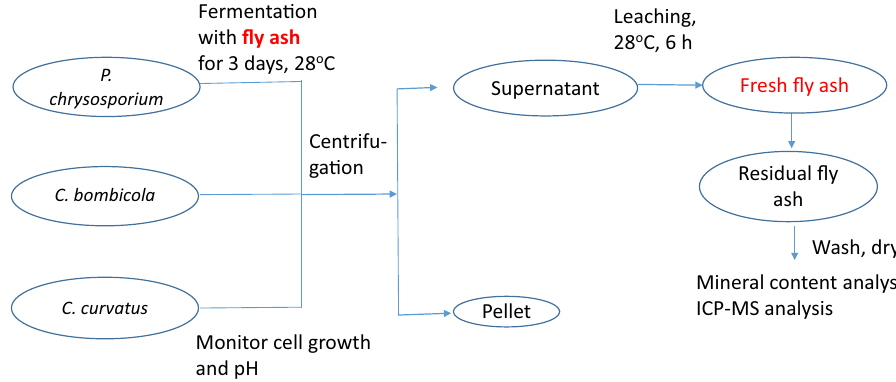
Fig. 1 The overall experimental